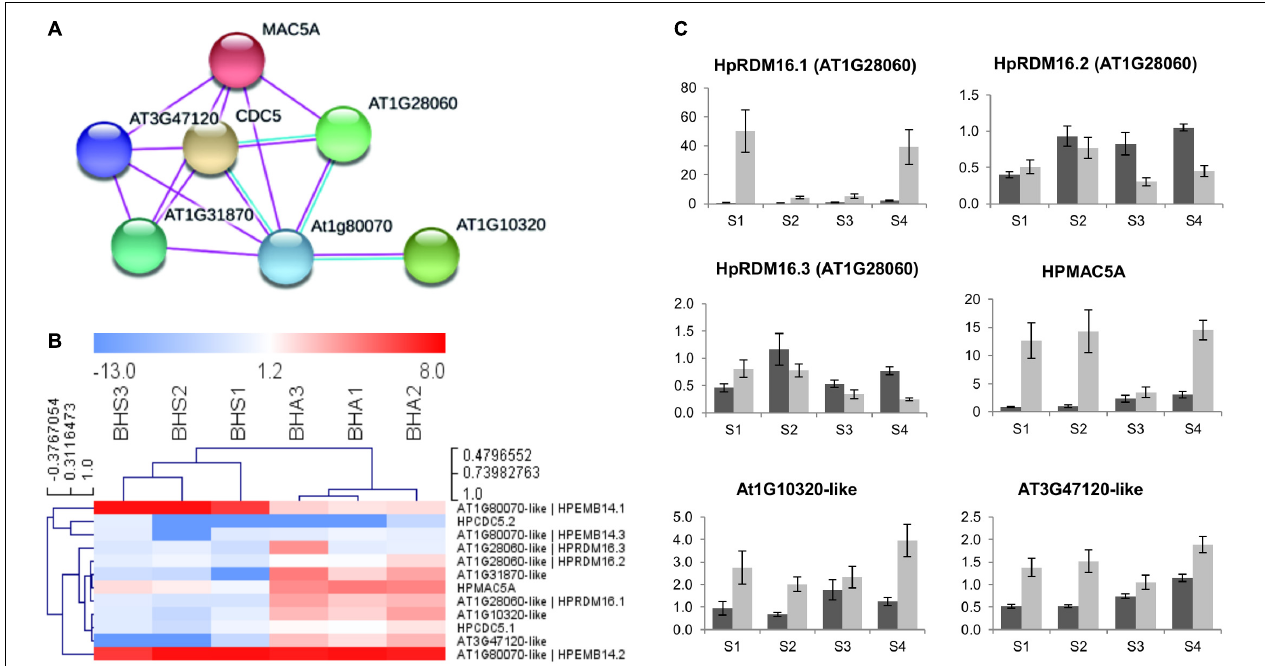
FIGURE 7 | Expression of H. perforatum loci involved in RNA processing and splicing. (A) Network showing known interactions between proteins encoded by the same loci. Nodes represent A. thaliana orthologs, while edges represent protein–protein interactions. Only known interactions from curated databases (blue) or experimentally determined (pink) were considered. The average local clustering coefficient is 0.876. The PPI enrichment p -value is 5.8e-5. (B) Heat map showing the expression of transcript variants in ovules dissected from sexual and aposporic accessions, as assessed by RNAseq. The HCL was performed by using Manhattan distances and average linkage clustering. (C) Quantitative Real-Time PCR results and known interactions for a number of H. perforatum DEGs potentially involved in RNA processing. Light gray bars: relative expression level in sexual pistils; dark gray bars: relative expression level in aposporous pistils. Pistil developmental stages: S1: pre-meiosis; S2: meiosis; S3–S4 early and late gametogenesis, respectively. Relative expression values are plotted on the vertical ax. Error bars indicate the standard error observed among the five biological